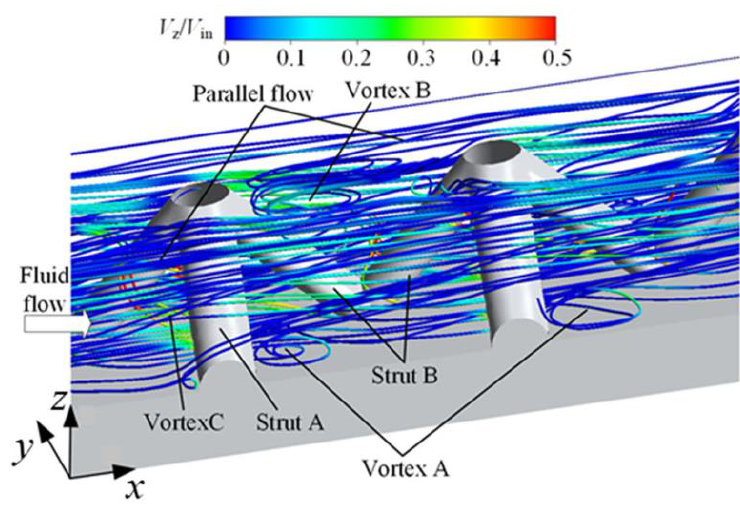
Figure 3. Vortices generated around pyramid lattice struts in a parallel flow regime.